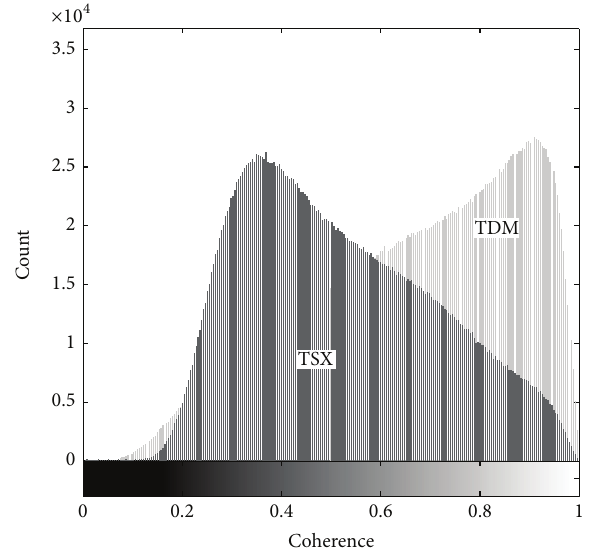
Figure 17: Coherence histogram comparison between TerraSAR-X and a TanDEM-X product (TSX) with 110 days 𝐵 temp